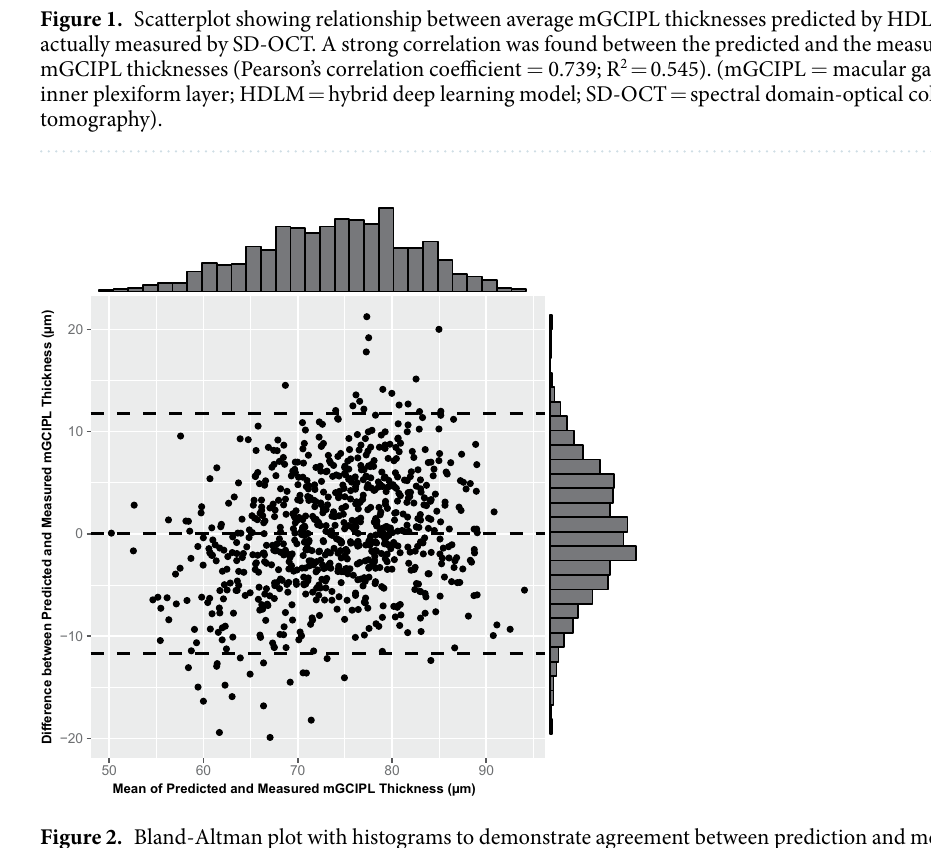
Figure 2. Bland-Altman plot with histograms to demonstrate agreement between prediction and measurement. The predicted mGCIPL thickness showed good agreement with the actual measurement (95% confidence limits [ − 11.7 µ m, 11.8 µ m]). (mGCIPL = macular ganglion cell-inner plexiform